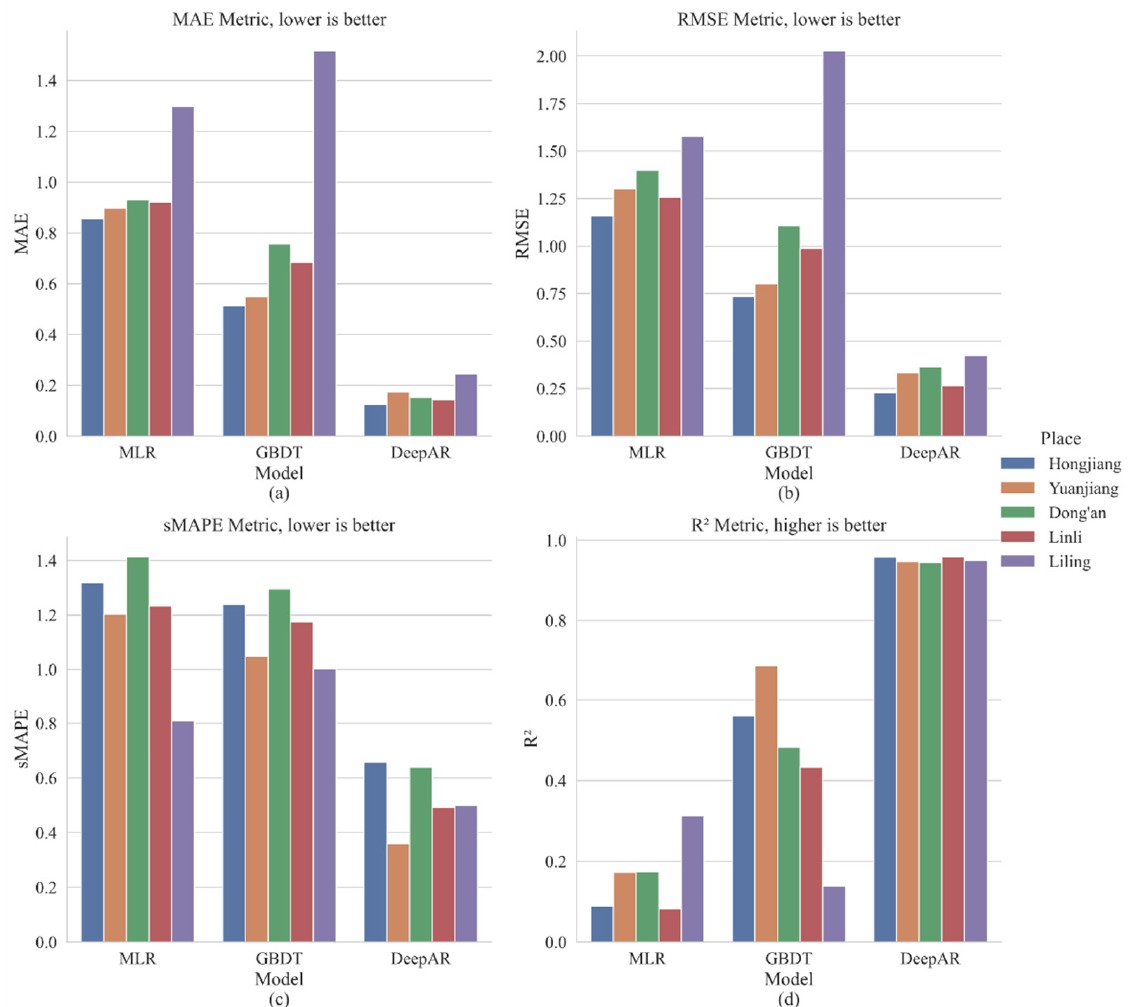
Figure 7. Predicted performance of MLR, GBDT, and DeepAR in different areas.